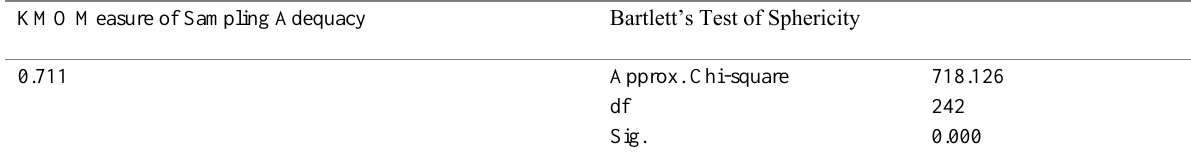
Table 4 : Test for Suitability of the Structure Detection